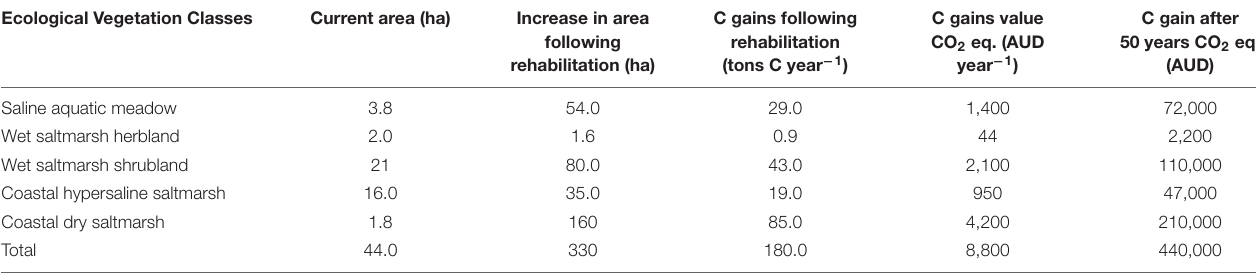
TABLE 1 | Current EVC area (hectares) at the recovered site and salt ponds and the potential area (hectares) following rehabilitation. Ecological Vegetation